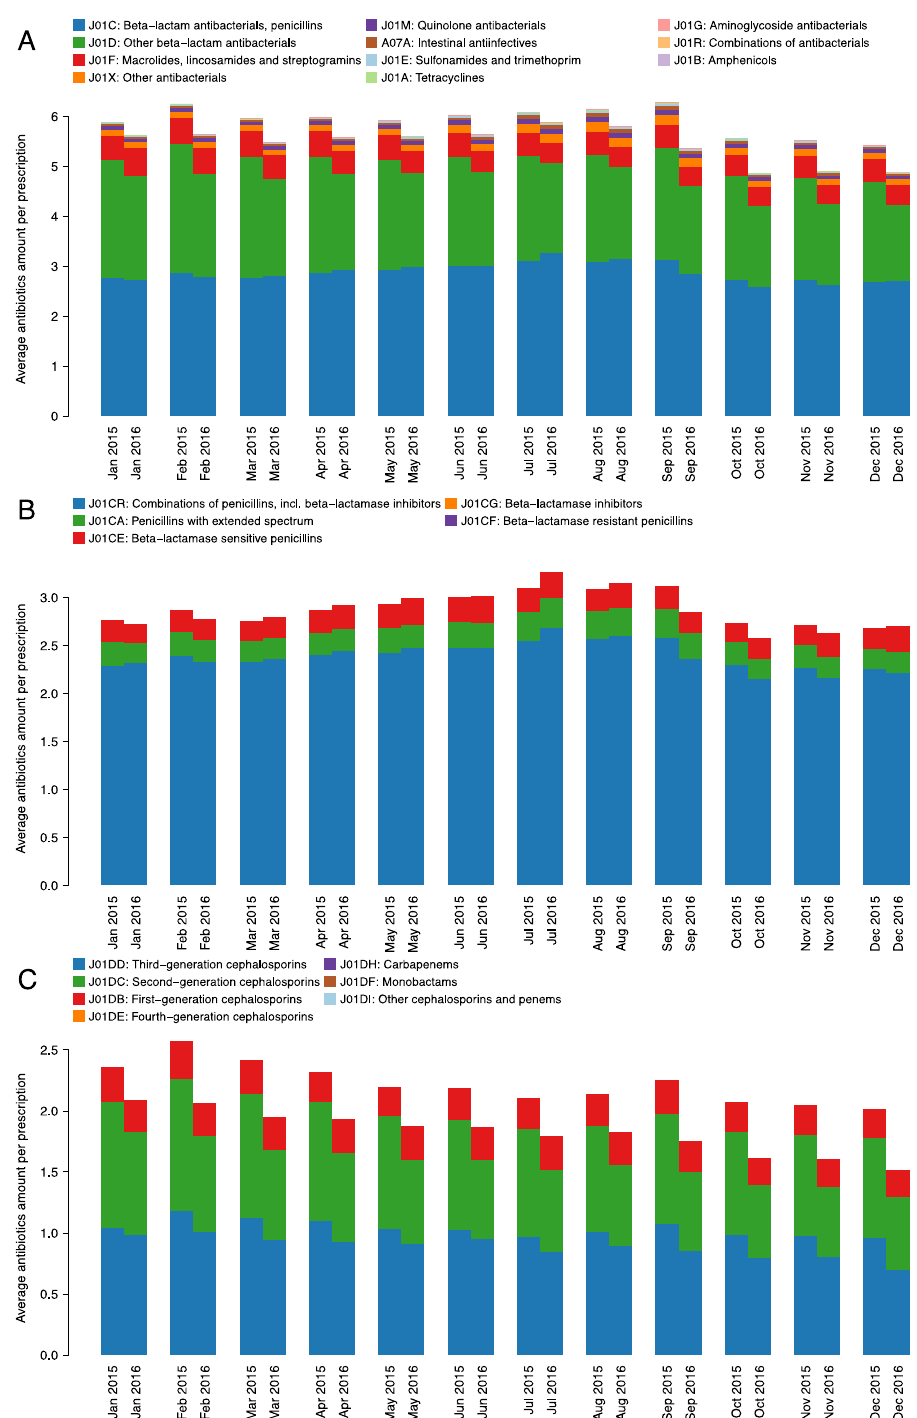
Figure 2. Monthly average antibiotics amounts per prescription for Turkey among the diagnosis of “acute upper respiratory infections” in 2015 and 2016. ( A ) Breakdown with respect to third level ATC codes, ( B ) Breakdown with respect to “beta-lactam antibacterials, penicillins” (i.e., ATC code J01C), and ( C ) Breakdown with respect to “other beta-lactam antibacterials” (i.e., ATC code